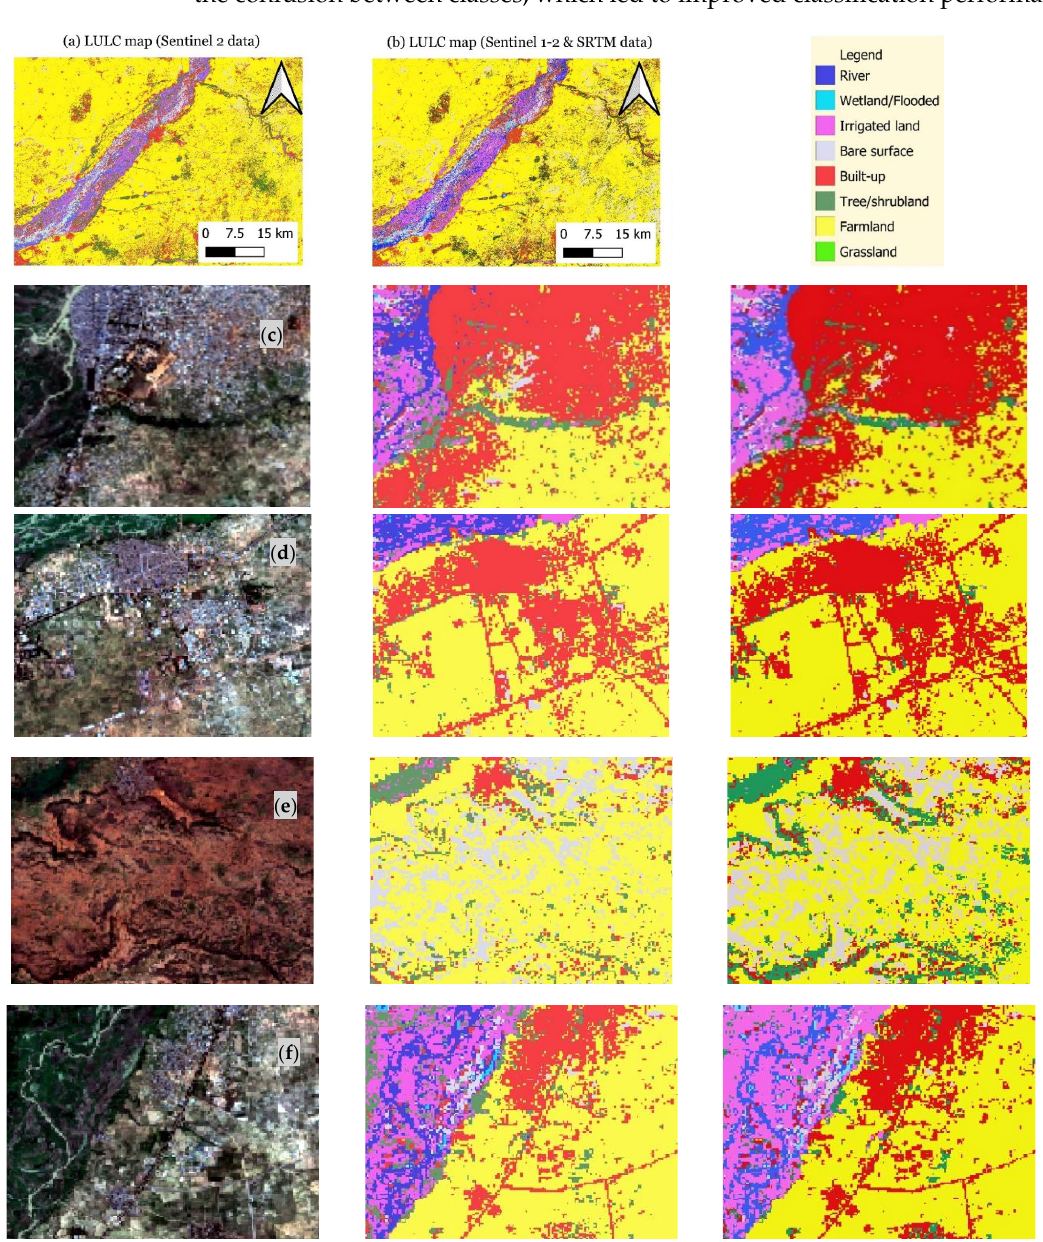
Figure 5. LULC maps ( a ) LULC map derived from Scenario 1 (Sentinel-2) ( b ) Scenario 4 (LULC map derived from Sentinel-1, -2 and SRTM elevation data), ( c – f ) four areas extracted from the RGB composite of Sentinel-2 and their corresponding locations in the two maps presented in ( a ) and ( b ).